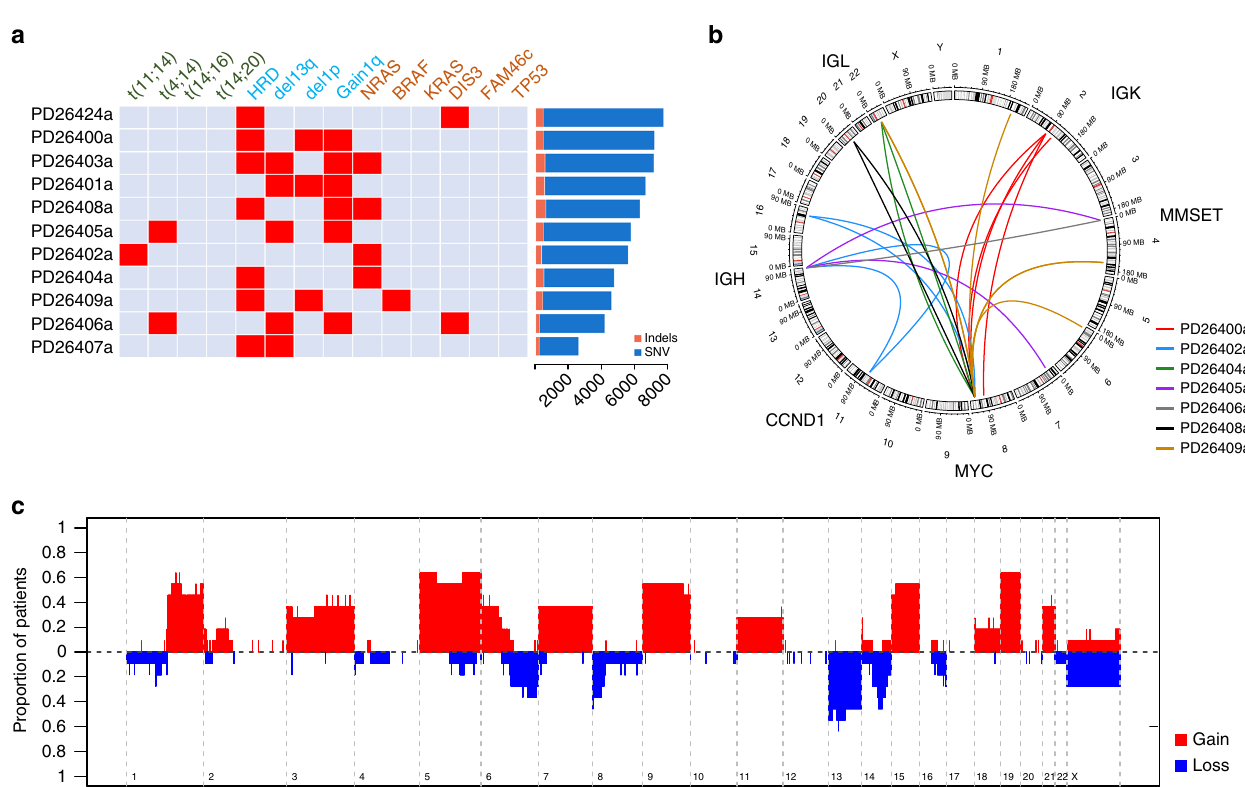
Fig. 1 The genomic landscape of smoldering multiple myeloma. a Map representing the prevalence of known driver events among 11 smoldering MM patients. On the right the bar plot shows the number of somatic mutations (substitutions and indels) in each patient. b Circos plot representing the recurrent MM translocations in MM identi fi ed in this study ( IGH and MYC genes). c Cumulative prevalence of clonal copy number